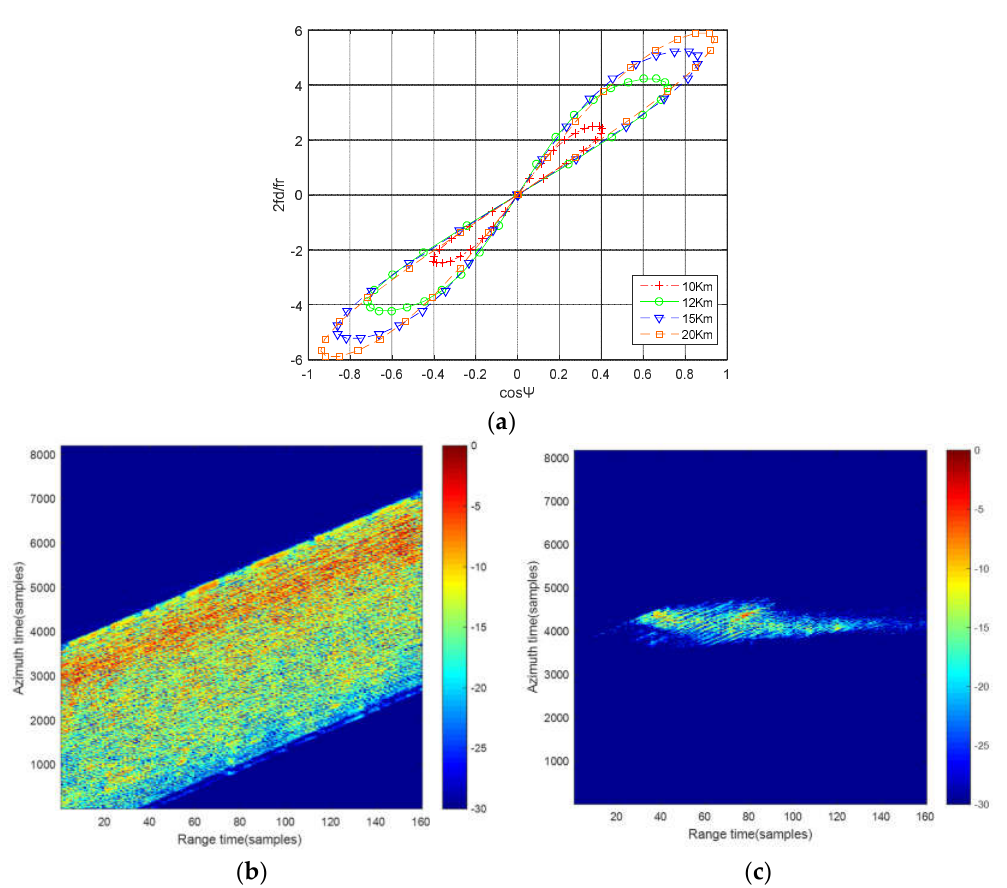
Figure 3. Time-division STACC process under close distance situation: ( a ) Clutter ridge of BFSAR; ( b ) The raw data before time-division STACC; ( c ) The result of two-channel time-division